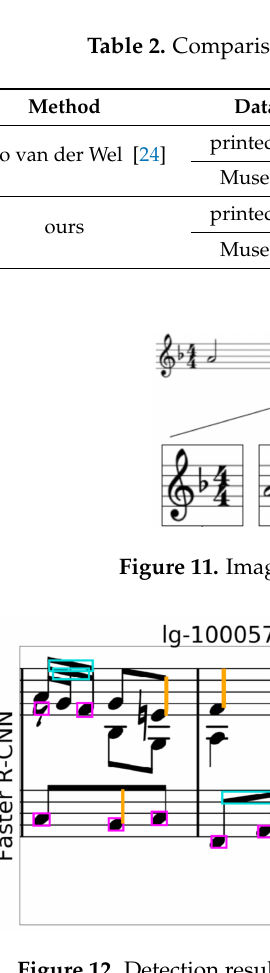
Figure 12. Detection results on DeepScores:image from Pacha et al.